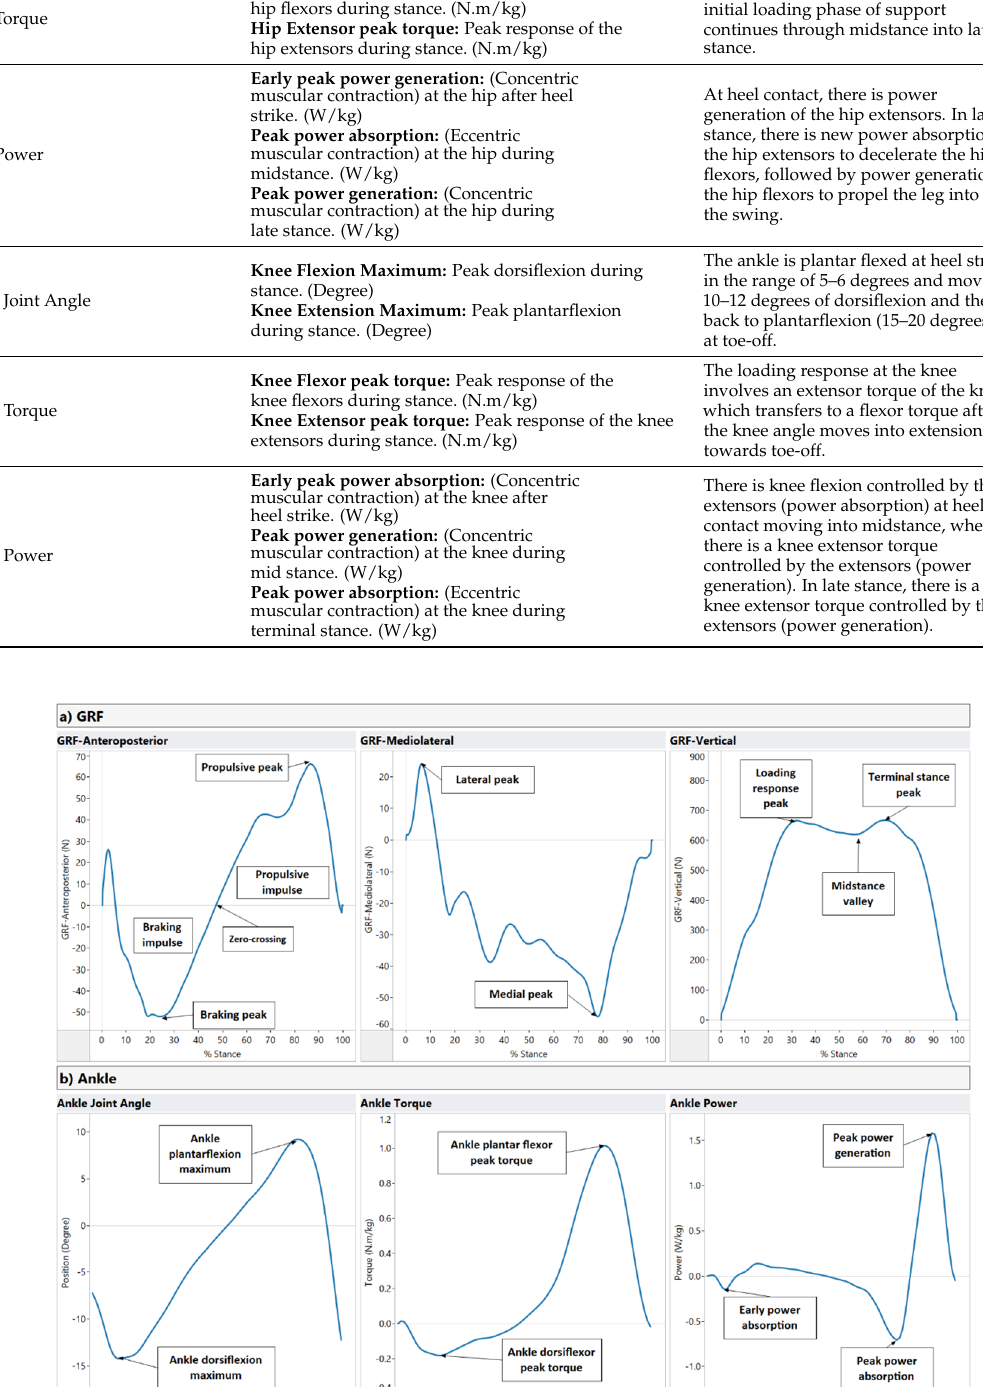
Figure A1. Gait features extracted from raw biomechanics data. a ) Ground reaction forces (GRF) raw signals and the peak points extracted, b ) Ankle, c ) Hip, and d ) Knee raw signals with the peak points extracted.